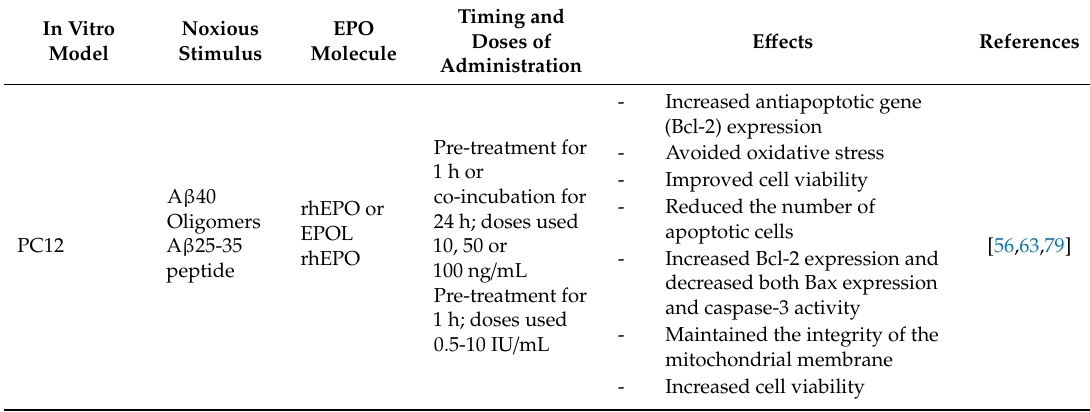
Table 2. In vitro AD